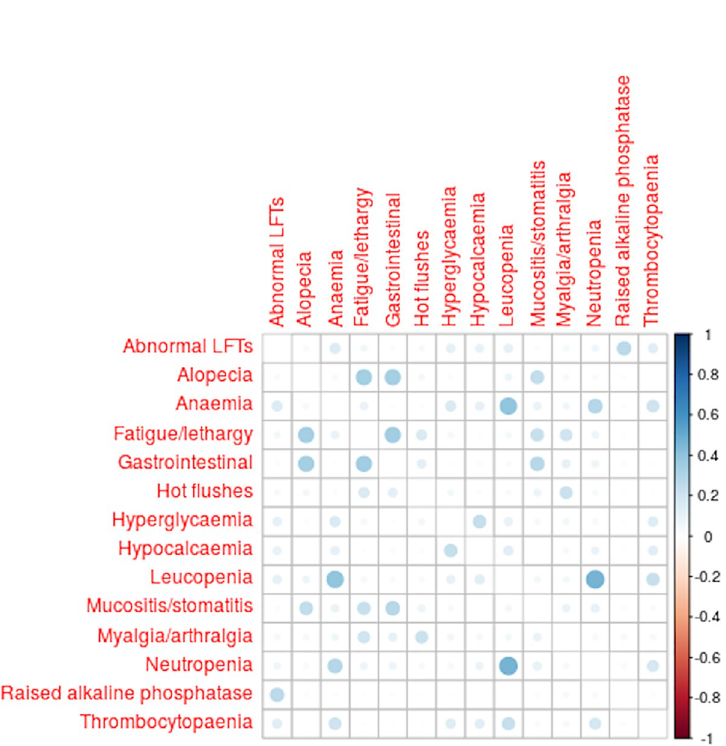
Fig 5. Correlation coefficients between different adverse events, as observed in the patients in the AZURE trial randomised to zoledronic acid. Area of dot is proportional to the correlation coefficient. The graph includes only the events which occurred in more than 5 out of these 1665 patients, and had a correlation of 0.2 or more with at least one other event. (produced using the corrplot R package [33]).